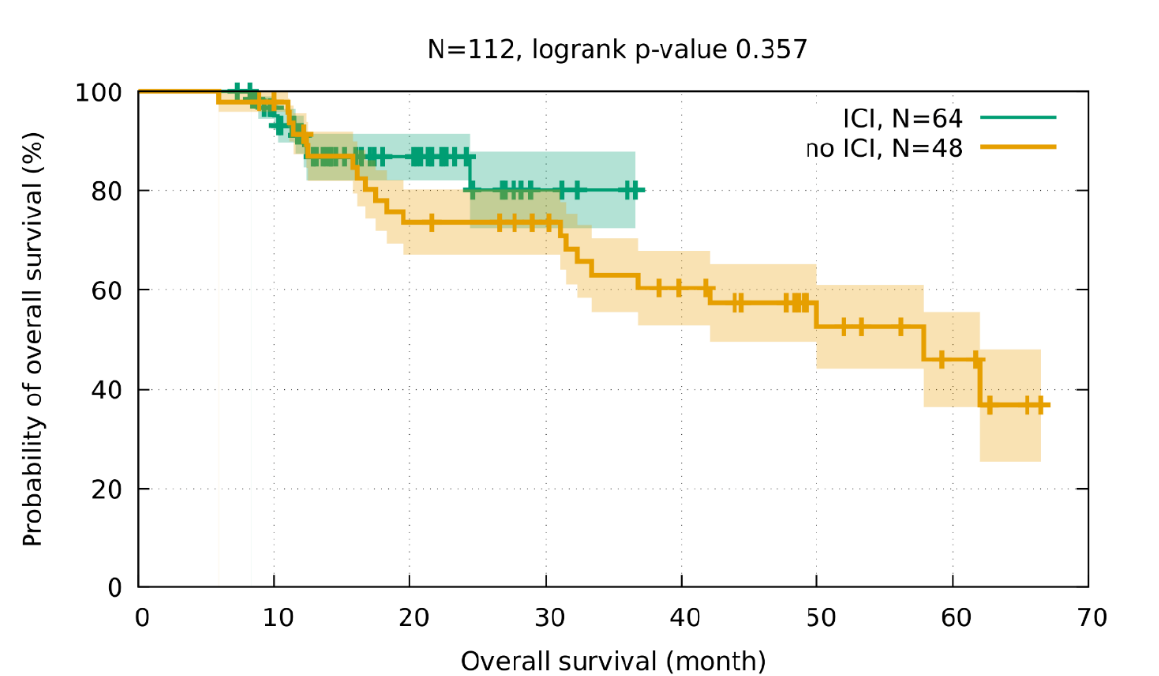
Figure A1. Overall survival did not differ significantly between the subgroups of patients with or without immunotherapy (logrank p -value = 0.357).